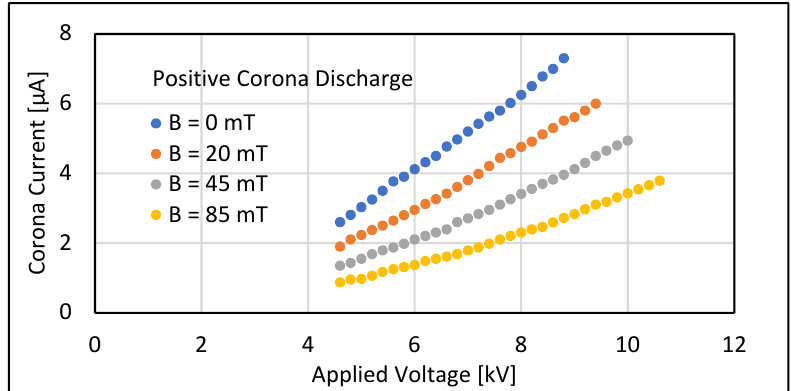
4 Figure 2. The schematic diagram of the experimental setup. The magnet coil was surrounded the cylinder tube and insulated by a Teflon tube of 6 cm diameter. The alignment of the magnetic field was organized in such a manner as to provide a uniform and homogenous distribution of the crossed magnetic field along the gap between the electrodes. Analysis software was performed to determine corona pa-